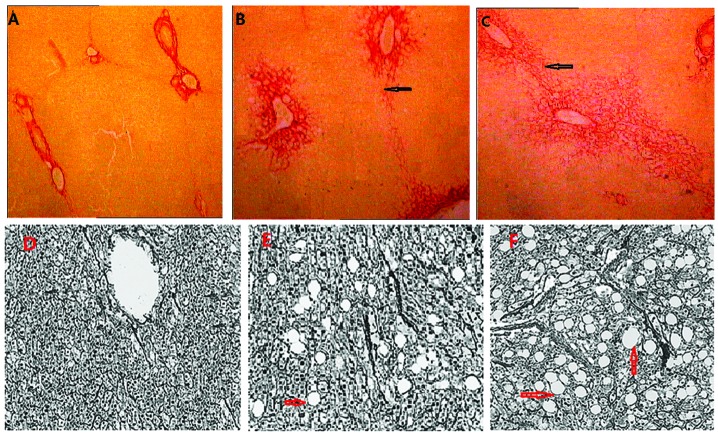
Picrosirius red (A–C) and silver (D–F) staining of the rabbit liver (magnification, ×200). Microscope images: (A) Normal rabbit liver, a small number of fibrous tissues were observed in the portal area. (B) Non-alcoholic fatty liver, fibrosis occurred around the portal area with fibrous septa forming in the lobule. (C) Alcoholic fatty liver, a large number of fibrous septa formed, which damaged the hepatic lobule. The red structures indicated by the arrows are fibrous tissues. (D) Normal rabbit liver, a small number of fibrous tissues were observed. (E) Non-alcoholic fatty liver, increased fibrosis occurred. (F) Alcoholic fatty liver, a large number of fibrous tissues were observed.